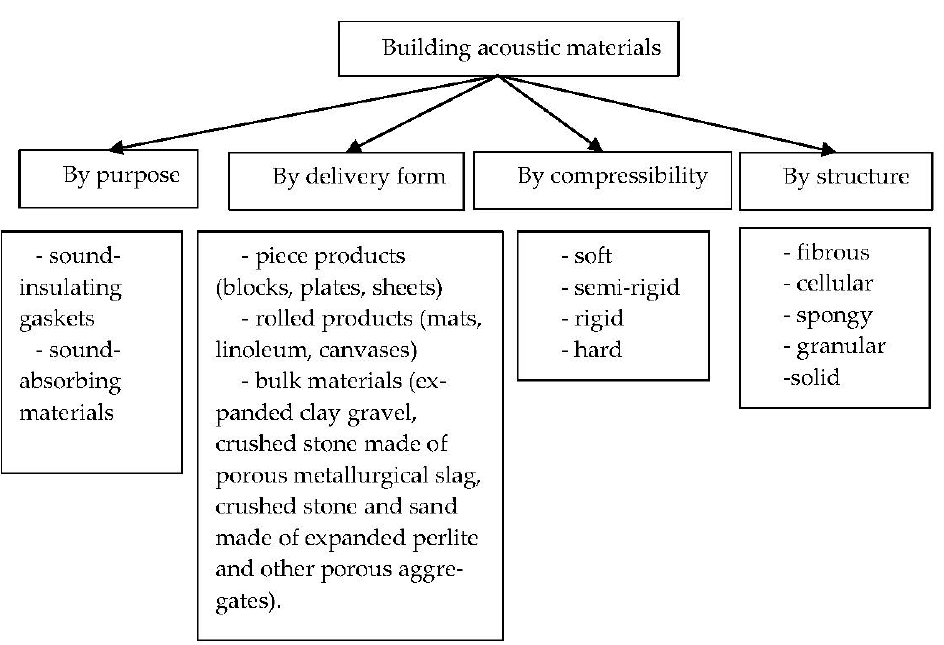
Figure 2. Possible combinations of sound-absorbing plaster and base material.